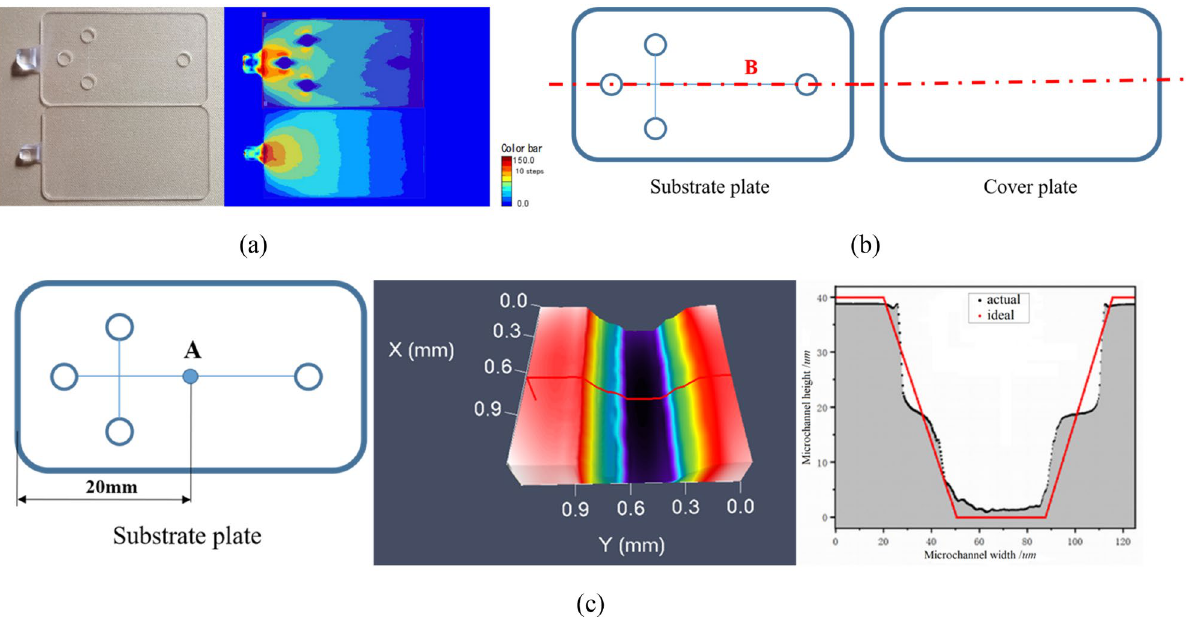
Figure 5. The measurement method of evaluation criteria for protein electrophoresis microfluidic chip. ( a ) The birefringence value. ( b ) The measuring position of warpage. ( c ) The measuring position and detail for replication fidelity of microchannel.